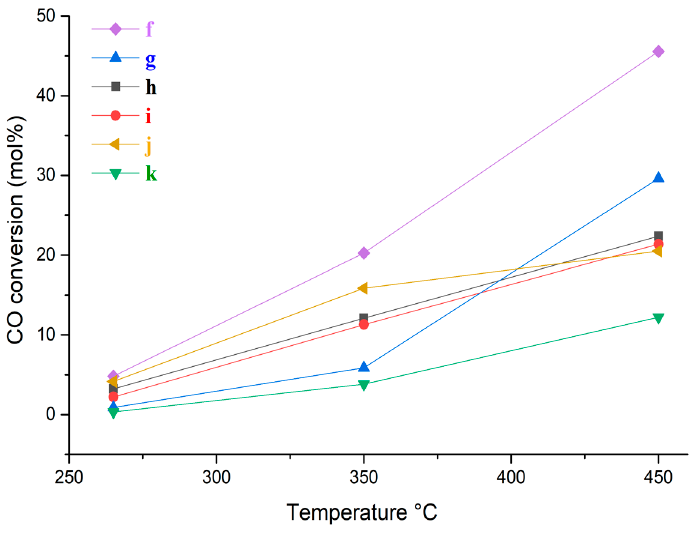
Figure 4. Laboratory test of CO conversion achieved by CATs deactivated for different reasons: ( f ) As poisoned; ( g ) caking 1; ( h ) water soaking; ( i ) caking 2; ( j ) Cl poisoned; ( k ) sintering by hot spot.